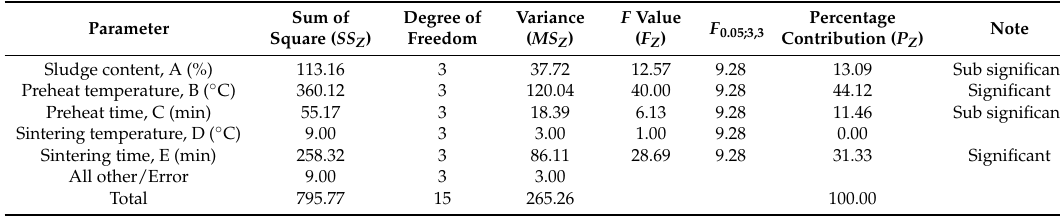
Table 9. Analysis of variance and F test for water absorption.